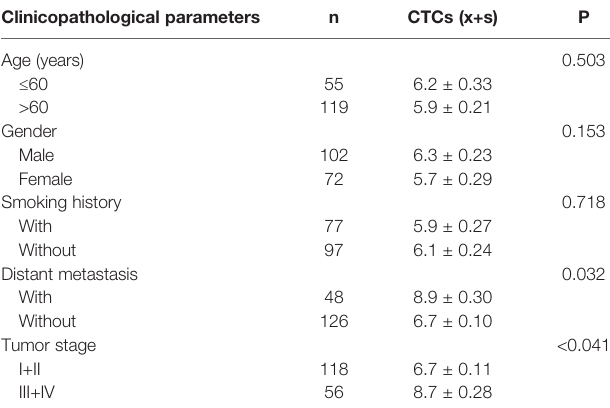
TABLE 1 | Correlation between CTCs count and clinicopathological parameters of patients. Clinicopathological parameters